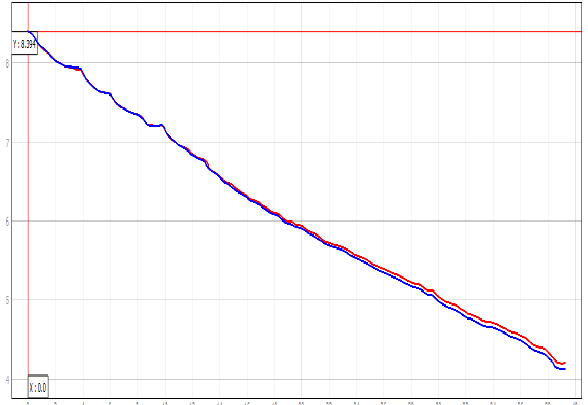
Figure 22b - Profile 1 Cross Section illustrates the red line (1 st survey) is approximately 5cms above the blue line (2 nd survey 48 hours later) after 20